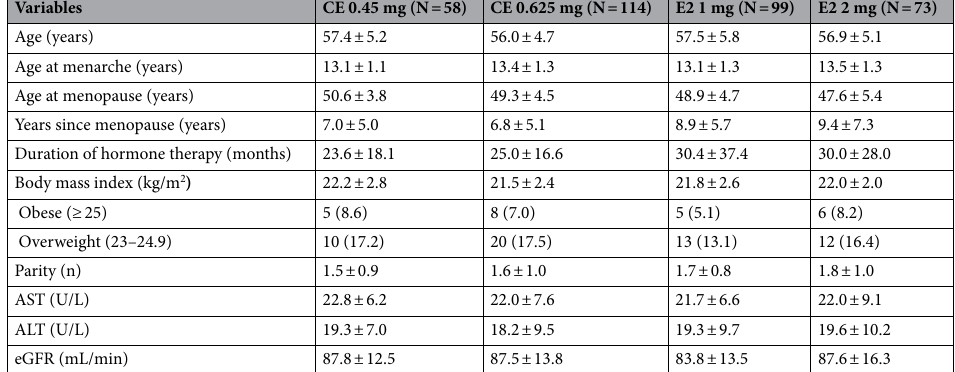
Table 2. Characteristics of the study population. Data are presented as mean ± SD or number (percent). No significant difference was found for all comparisons. E2 estradiol, AST aspartate aminotransferase, ALT alanine aminotransferase, eGFR estimated glomerular filtration